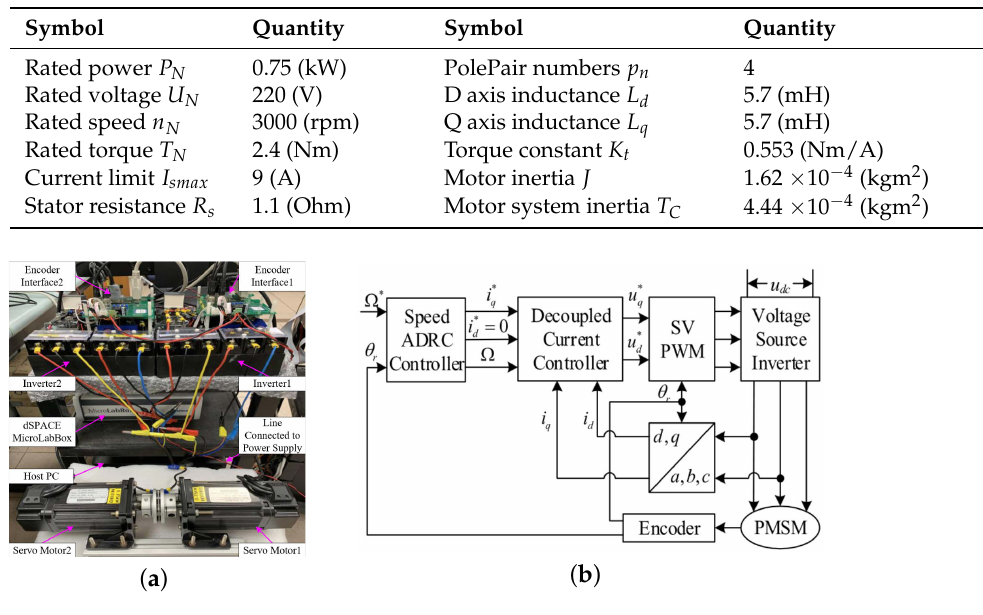
Figure 5. Test bench: ( a ) configuration and ( b ) block diagram.